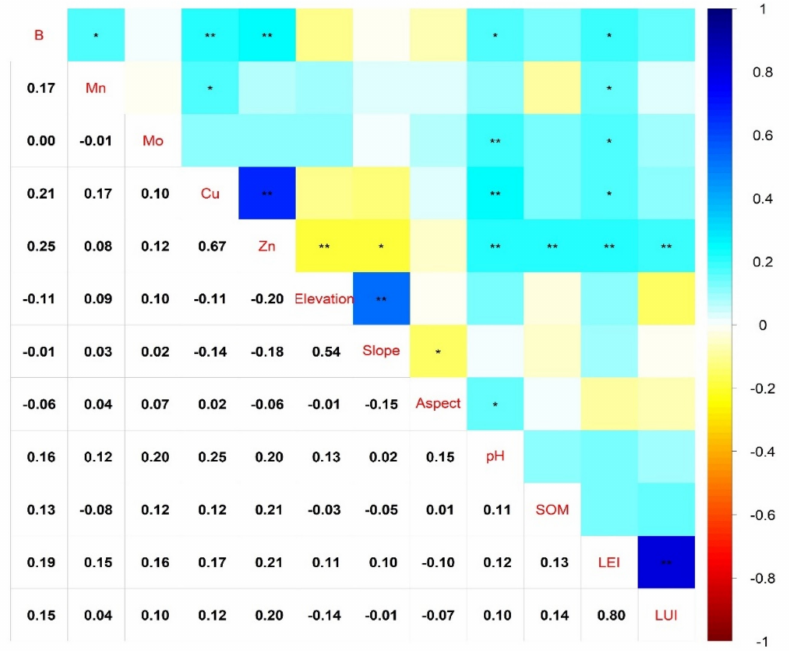
Figure 2. Correlation heat map of soil trace elements and influencing factors. B, boron; Mn, man- ganese; Mo, molybdenum; Cu, copper; Zn, zinc; SOM, soil organic matter; LEI, land economic index; LUI, land use index; * means p < 0.05; ** means p < 0.01.